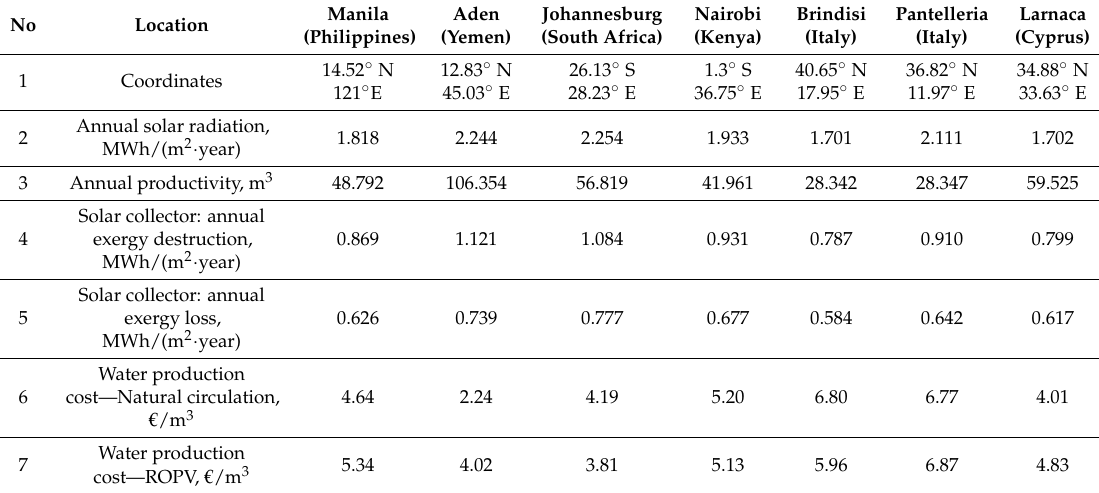
Table 3. Simulation results for all seven